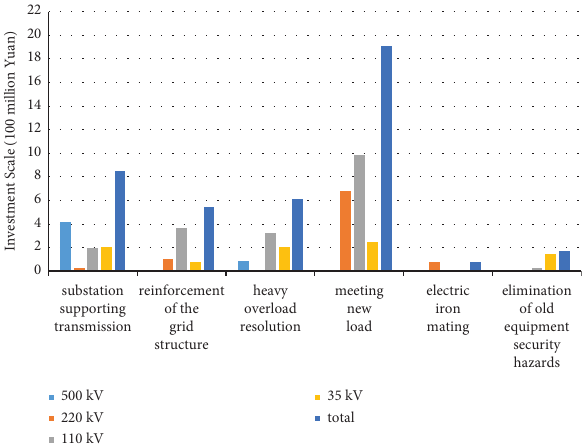
Figure 6: Optimal solution with a social beneft objective at 500kV/220kV/110kV/35 kV voltage levels.